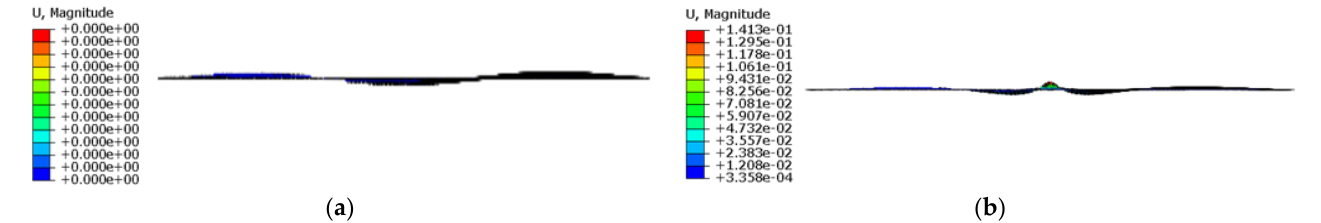
Figure 8. The initial deformation: ( a ) plate with prefabricated crack; ( b ) plate with fatigue crack (When cyclic tensile load unloading to zero).